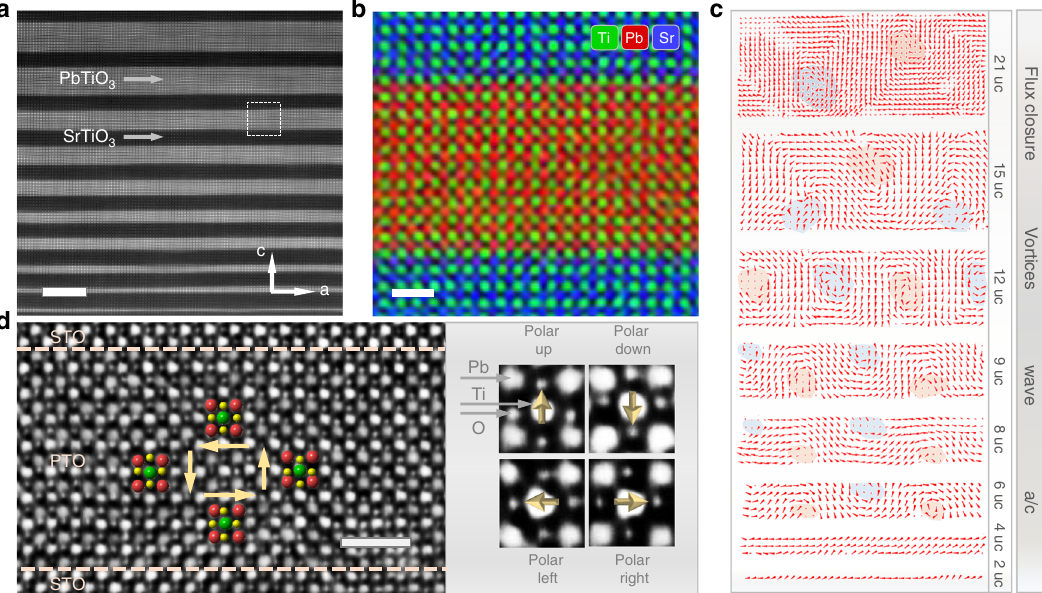
Fig. 1 Structural characterization of the PTO ( n ) /STO (10) multilayer. a HAADF-STEM image of the fi lm, recorded with the incident electron beam parallel to the [010] pc direction. Scale bar, 10 nm. b EDS-mapping of Pb, Sr, and Ti shows that the interface of PTO/STO is atomically sharp. This region is extracted from the white box in a . Scale bar, 1 nm. c Ti atom displacement vector maps based on experiment, showing the domain evolution with changing PTO thickness. Red and blue regions indicate the clockwise and counterclockwise vortex pairs 59 – 61 . d Superposition of the iDPC-STEM image and a structure model of PTO, showing the atom displacements around the vortex structure. The red, green, and yellow dots denote the positions of Pb 2 + , Ti 4 + , and O 2- columns, respectively. Arrows denote the polarization direction. The dashed lines indicate the interface between PTO and STO. The zoom-in images attached to this iDPC-STEM image exhibit the unit cell of PTO along [010] pc in which positions of Ti, O, and Pb are clearly shown. Scale bar, 1